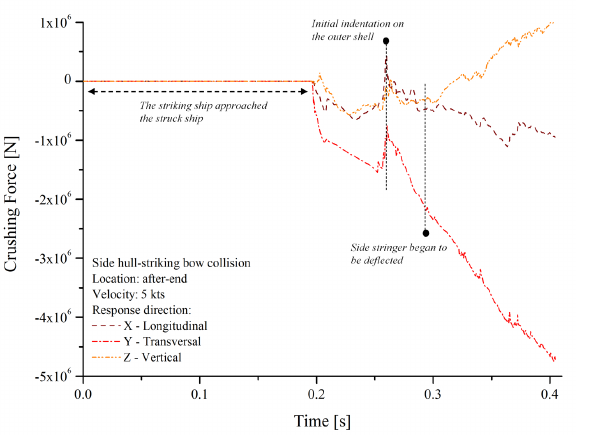
Figure 8: Force criterion and behaviour of the failure on the side hull: midsection impacted by velocity 5 kts.